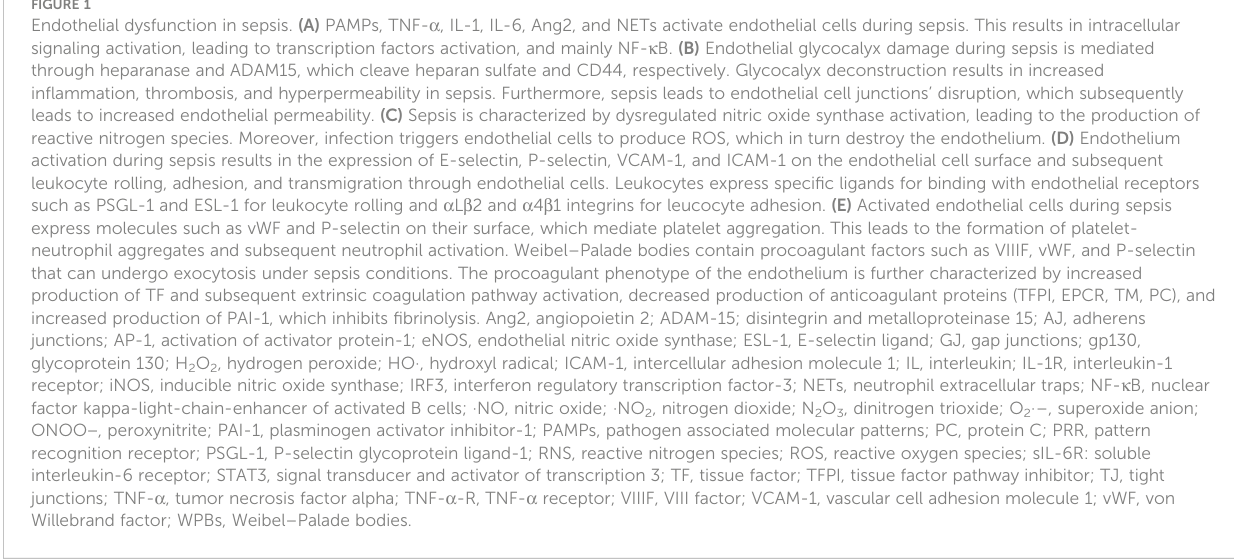
Willebrand factor; WPBs, Weibel – Palade